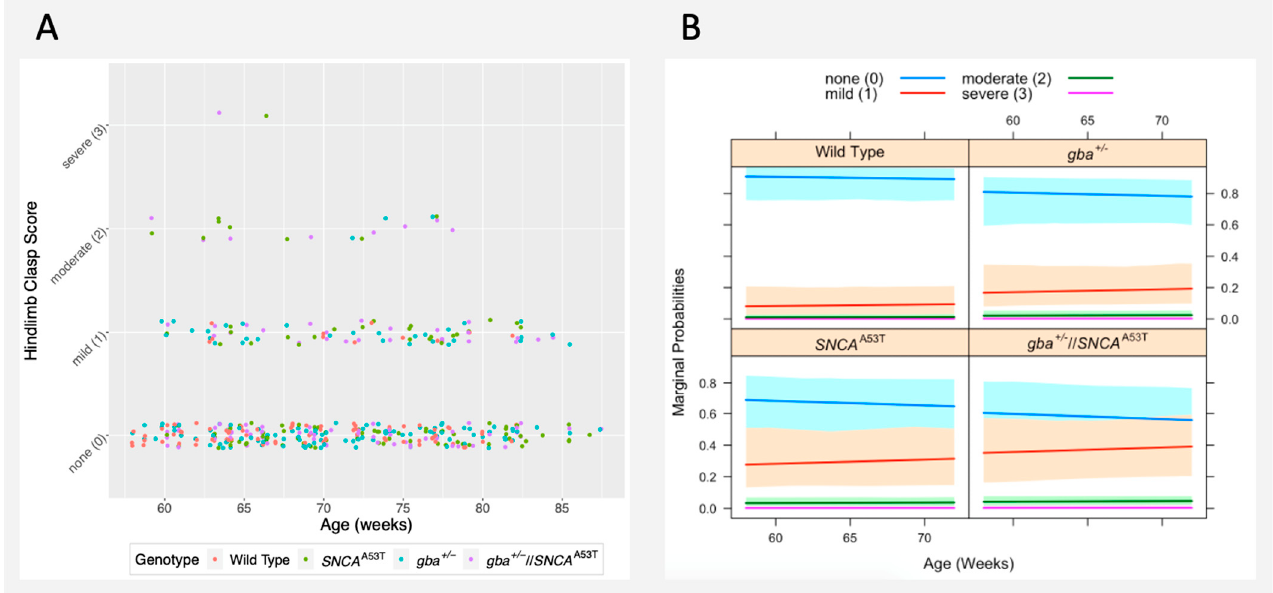
Figure 4. Hindlimb clasp performance: ( A ) hindlimb clasp observations recorded during the testing window (55–90 weeks), colored by genotype; ( B ) model-predicted probability of displaying a given phenotype during a particular week. Colored lines display the chance of exhibiting scores of 0 (no phenotype), 1 (mild phenotype), 2 (moderate phenotype), and 3 (severe phenotype). Graphs are segregated by genotype. Colored fill represents standard error.